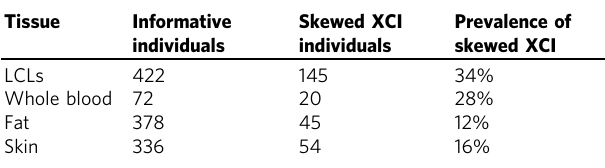
Table 1 Prevalence of skewed X-inactivation (XCI) differs across tissues in the TwinsUK